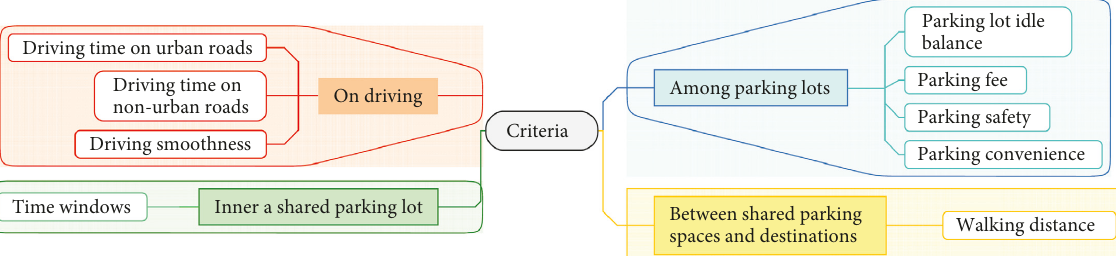
Figure 2: Multi-criteria for shared parking and parking route recommendations.